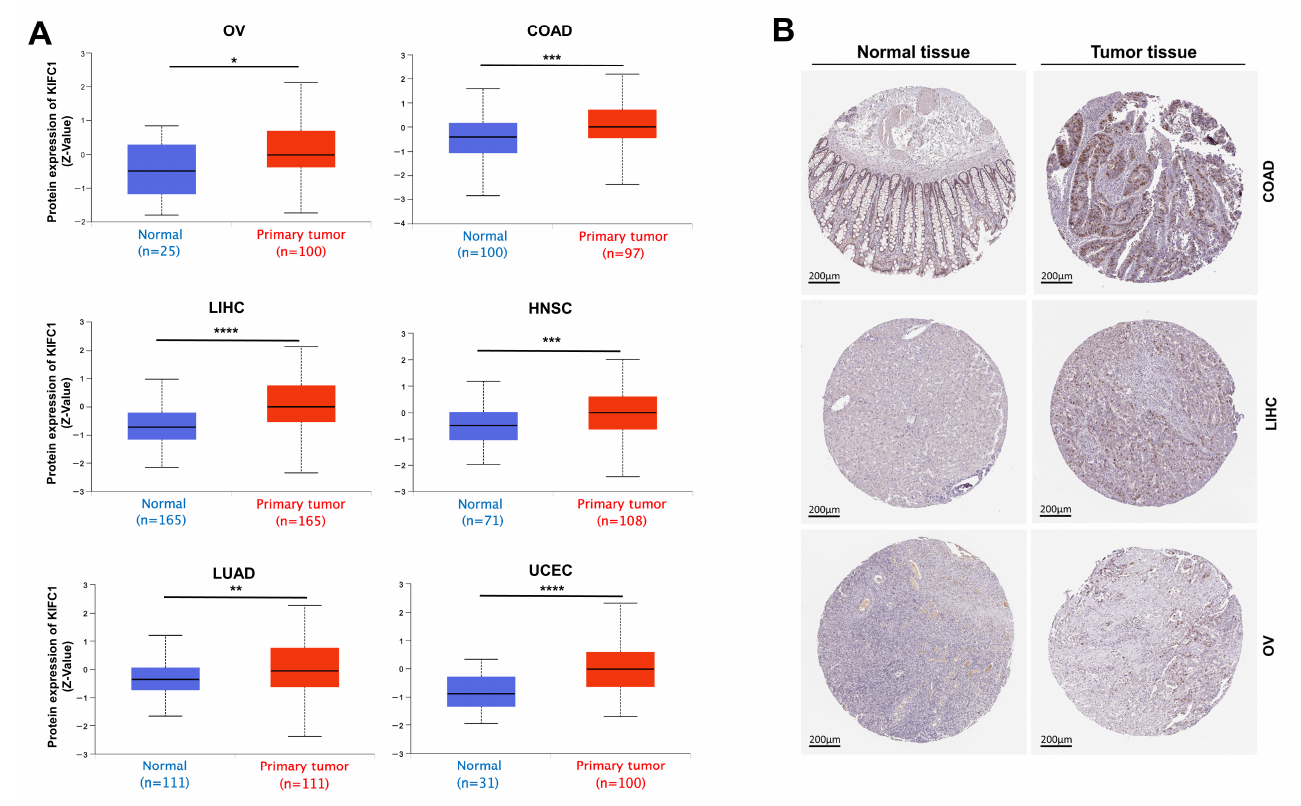
Figure 3. Protein expression of KIFC1 in different tumors. ( A ) The KIFC1 total protein expression between normal tissue and primary tumor tissue, according to the CPTAC database; Zvalues represent standard deviations from the median across samples for a given cancer type. * p < 0.05, ** p < 0.01, *** p < 0.001, **** p < 0.0001, in Student’s t test. TPM: transcripts per million. ( B ) KIFC1 immunohistochemistry staining images in human COAD, LIHC, and OV, compared with normal tissues from HPA database.